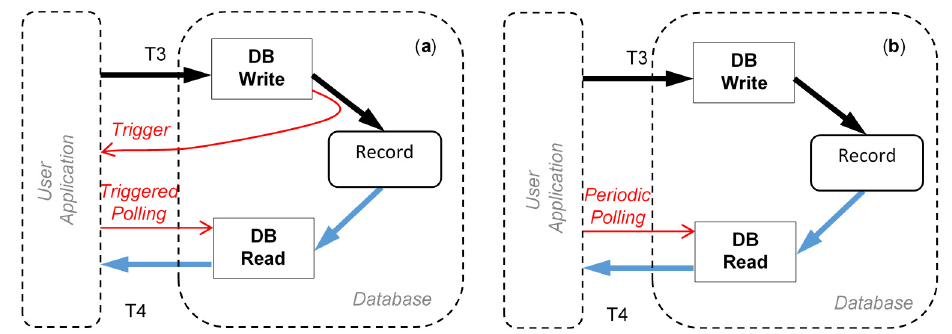
Figure 2. Two methodologies for retrieving data form Databases with a short latency. ( a ) The write action triggers a user function that reads back the recently written data; ( b ) The Database is polled regularly to fetch recently added data.